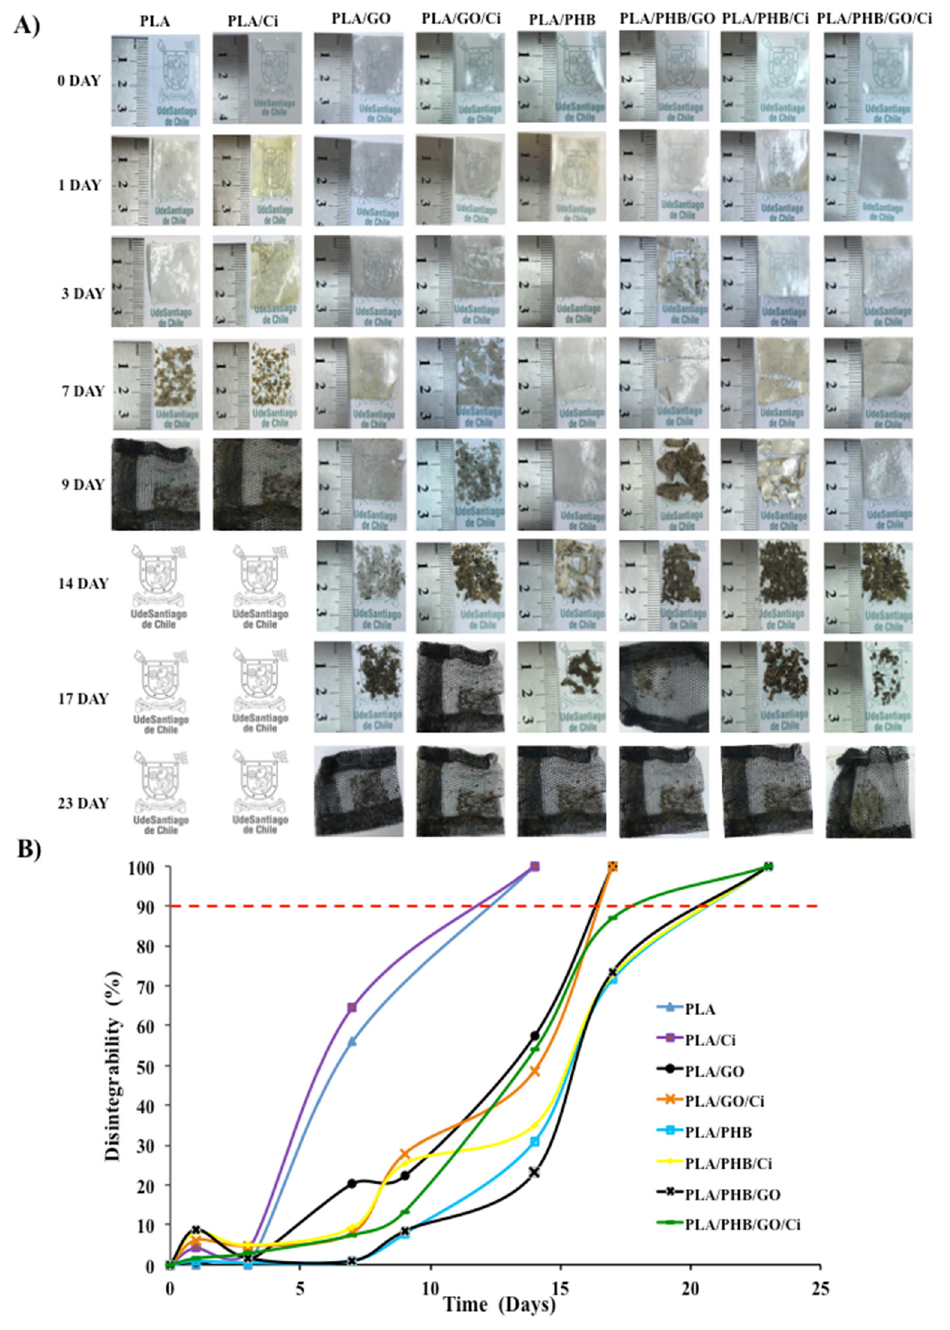
Figure 5. ( A ) Visual appearance of developed materials at different times under composting condi- tions, ( B ) Films disintegration degree under composting conditions as a time function. tions, ( B ) Films disintegration degree under composting conditions as a time